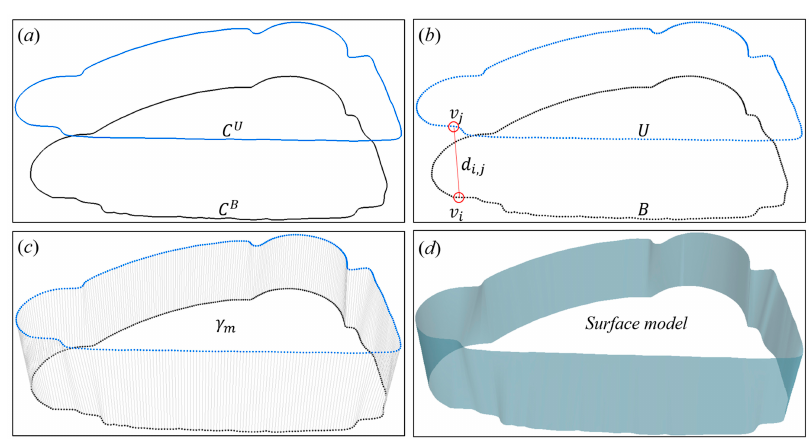
Figure 2. Bipartite graph matching: ( a ) two consecutive contours; ( b ) sets of nodes in two consecutive contours; ( c ) resulting matchings between the two sets of nodes in ( b ); and ( d ) the surface model.